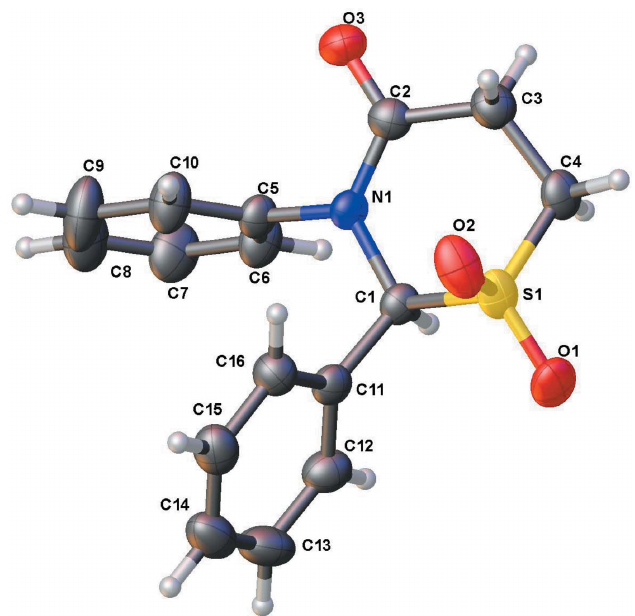
Figure 1 The asymmetric unit of 1 with displacement ellipsoids drawn at 50% probability